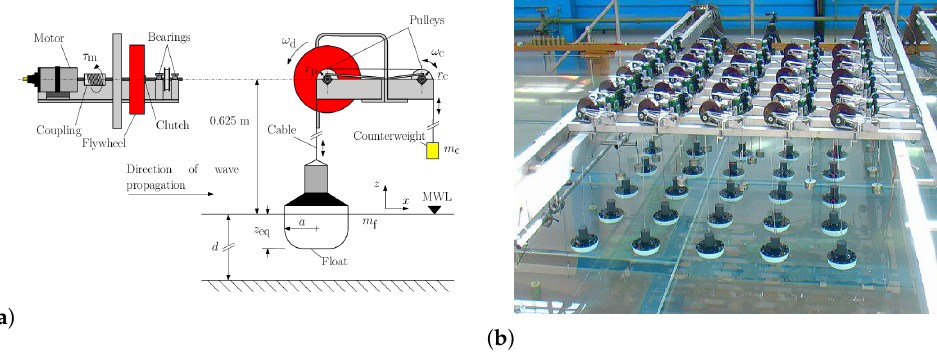
Figure 1. Experimental setup of the Manchester Bobber: ( a ) drawing of the WEC model, reprinted with permission from Ref. [34], 2010, Weller and ( b ) picture of the 5 × 5 WEC array in the wave flume of Manchester University, reprinted with permission from Ref. [35], 2008, Manchester